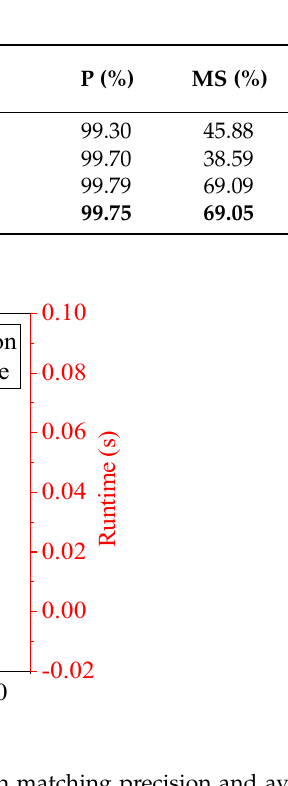
Figure 13. The impact of threshold of similarity on matching precision and average runtime on YFCC100M dataset.